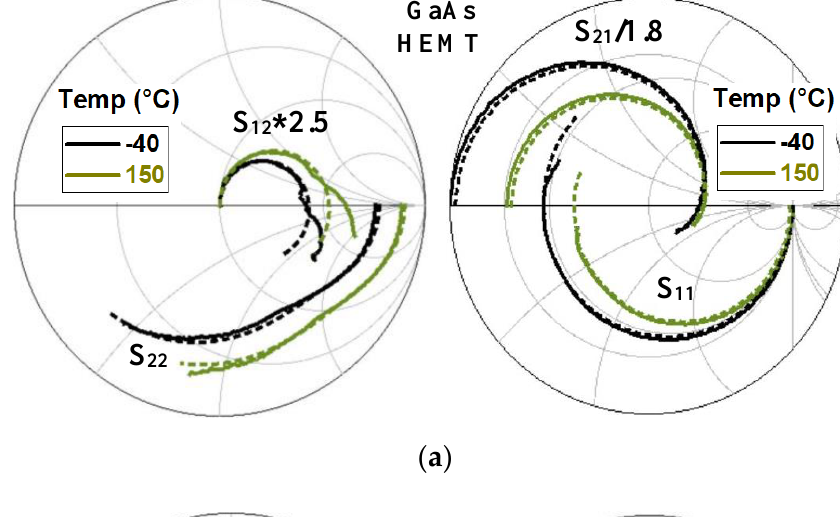
Figure 7. Equivalent-circuit model for the studied GaAs and GaN HEMTs.